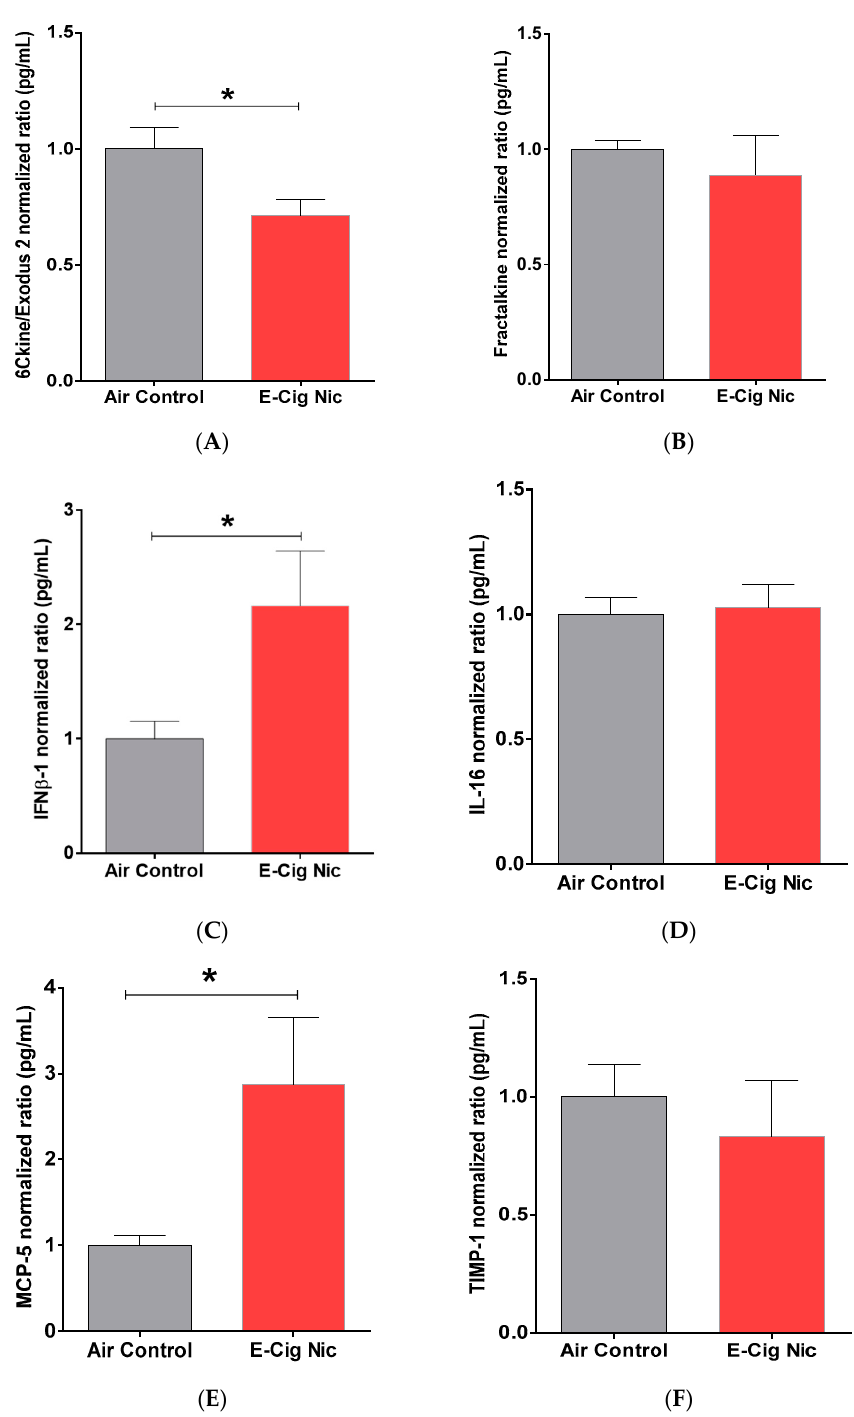
Figure 10. Brain concentration of neuro-inflammatory cytokines and chemokines in the Air Control and E-cig Nicotine groups after four-week inhalation of e-cigarette aerosols. ( A ) 6Cklne/Exodus 2. ( B ) Fractalkine. ( C ) IFN β -1. ( D ) IL-16. ( E ) MCP-5. ( F ) TIMP-1. N = 4–5/biological replicates (M or F = 2–3). and 8–10/technical replicates. Unpaired t test was used to compare each marker between air control and E-cig Nic groups. Data are presented as mean ± SEM. (* p < 0.05). E-cig, electronic ciga- rette; E-cig Nic, electronic cigarette with nicotine; F, female; M, male.